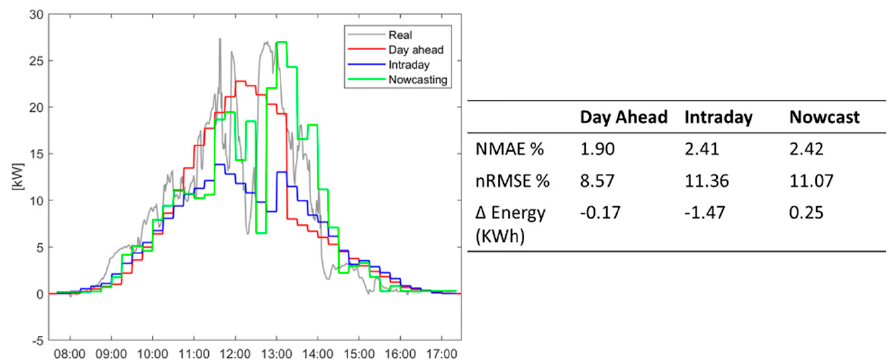
Figure 10. PV forecasts and real profiles—day 2.